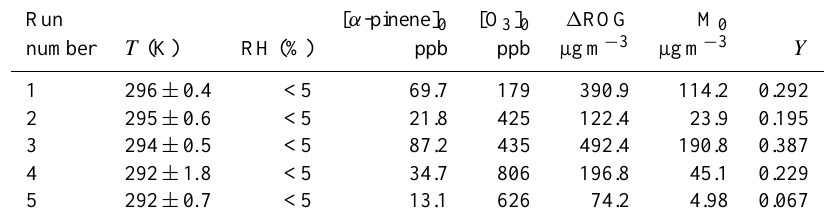
Table 6. Summary of initial conditions and results for α -pinene ozonolysis